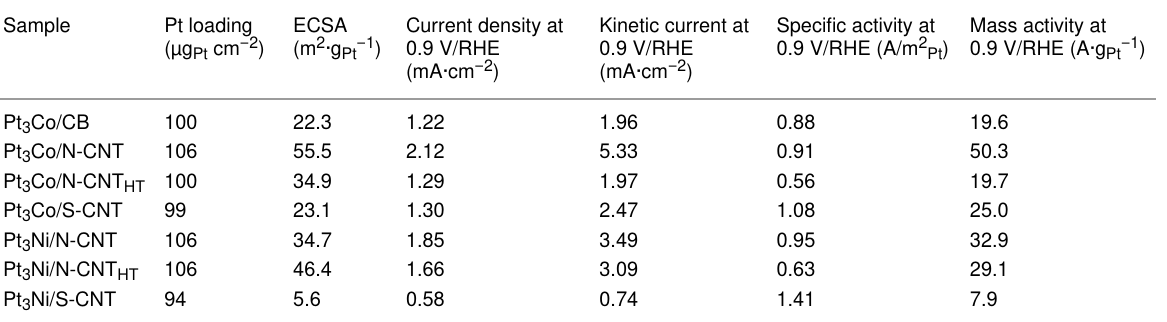
Table 4: Electrochemical surface area (ECSA), current density and i K at 0.9 V/RHE for Pt 3 M catalysts using RRDE experiments.